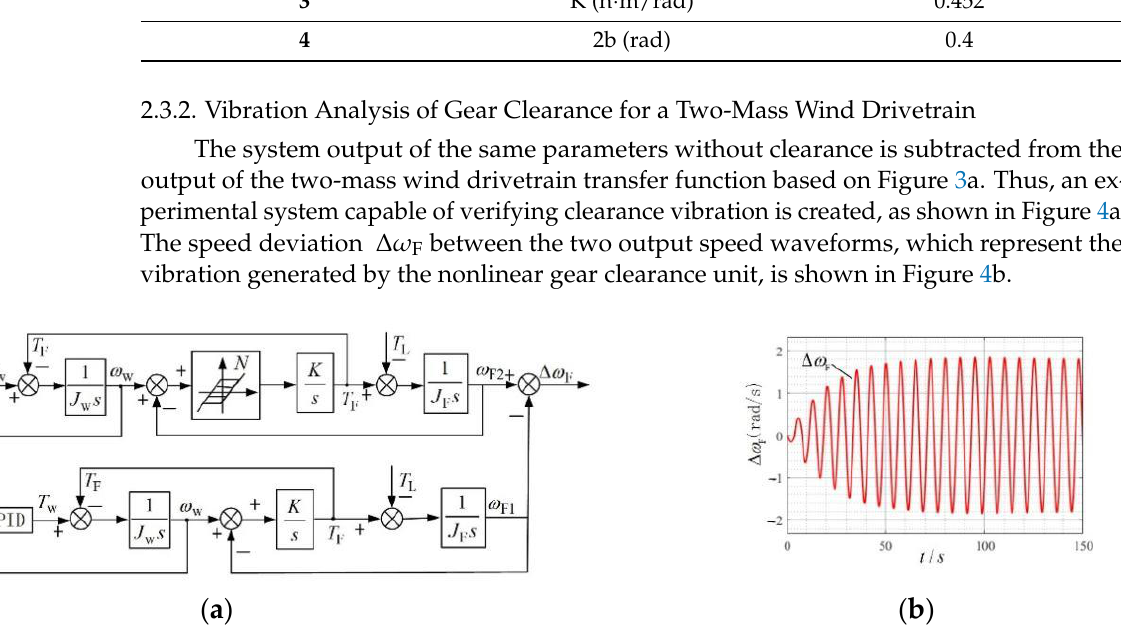
Figure 4. Experimental verification of the clearance vibration and vibration waveform: ( a ) experi- mental verification of the clearance vibration; ( b ) speed deviation waveform caused by clearance. * means the reference value.